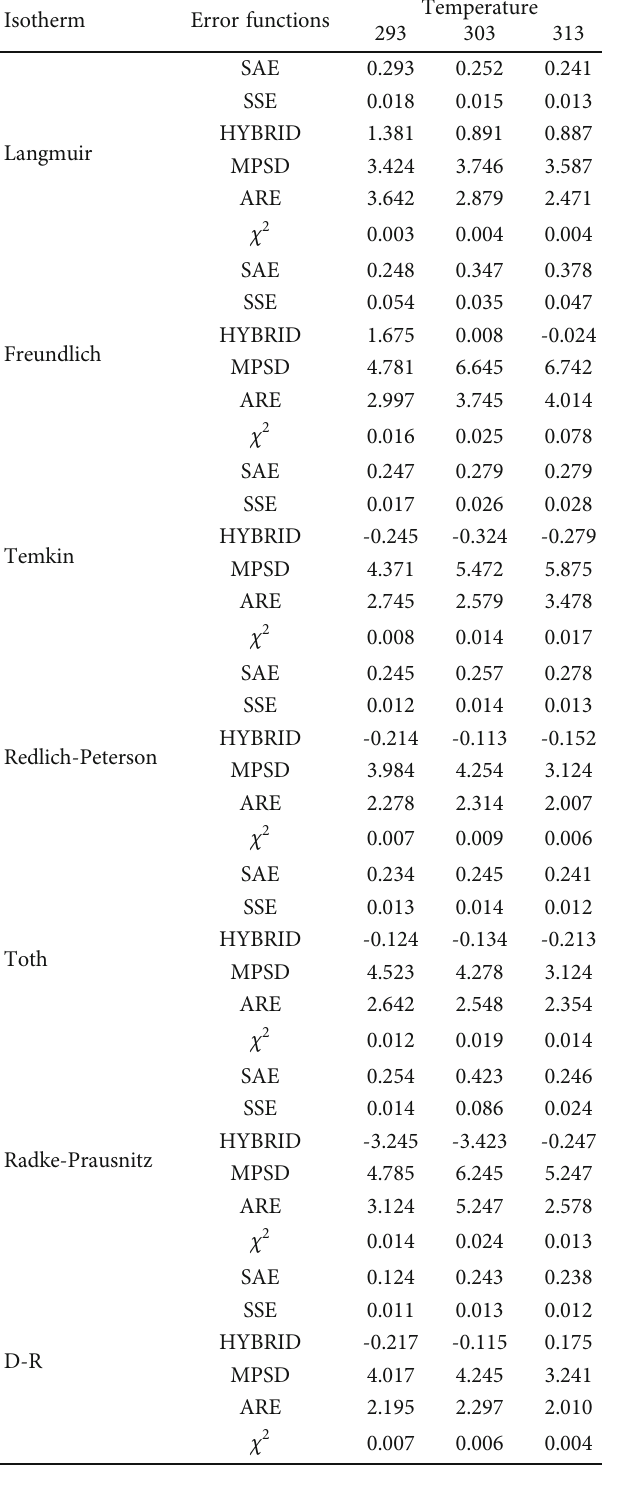
Table 7: Error functions for CV sorption onto ACMAS. Isotherm Error functions